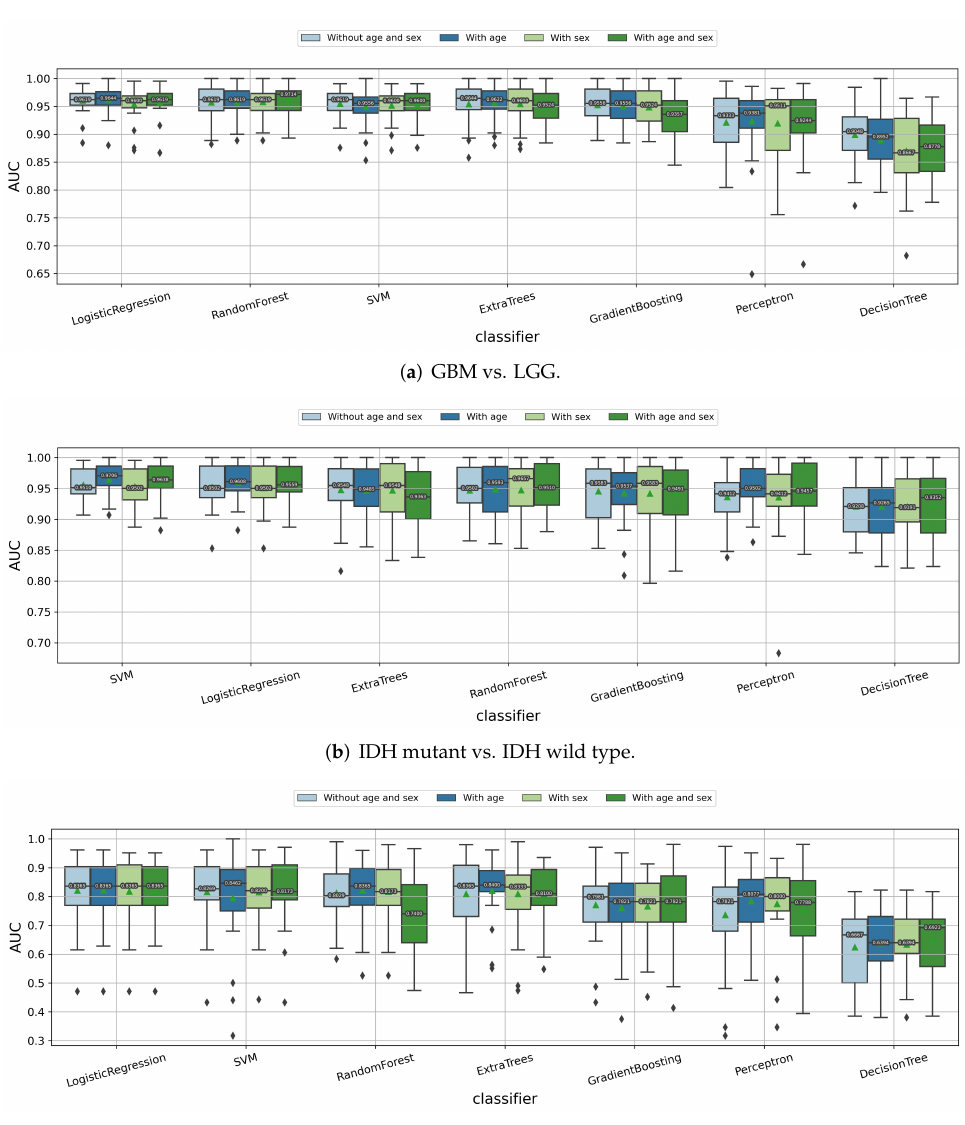
Figure 6. Impact of incorporating the age and sex information as additional features to predict ( a ) tumor grade, ( b ) IDH mutation status, and ( c ) 1p/19q codeletion status of the